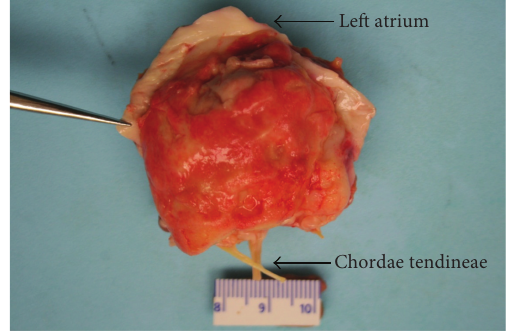
Figure 3: Macroscopic image shows the left atrial mass attached to the posterior wall of the left atrium and the entire posterior mitral leaflet, except for its free